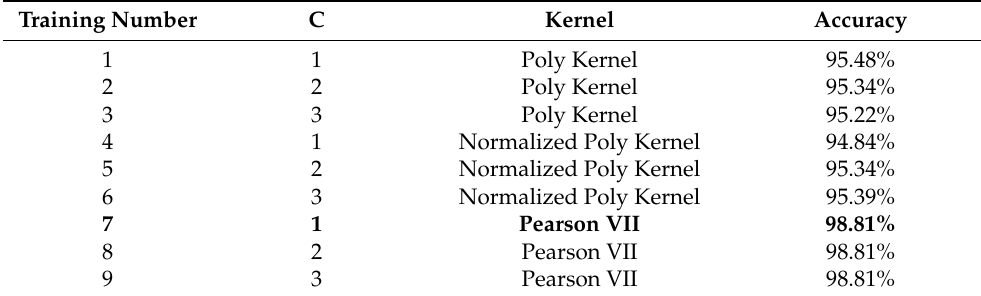
Table 6. SVM algorithm hyperparameter optimization results using C value and Kernel hyperparameters.